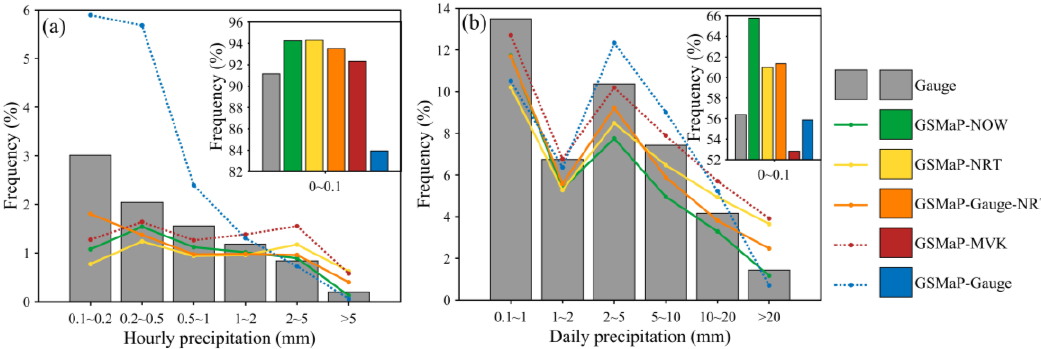
Figure 5. Comparison of the frequency distribution of the GSMaP precipitation estimates with those of the ground observations from 29 March 2017 to 31 December 2018: ( a ) hourly and ( b ) daily time scales.